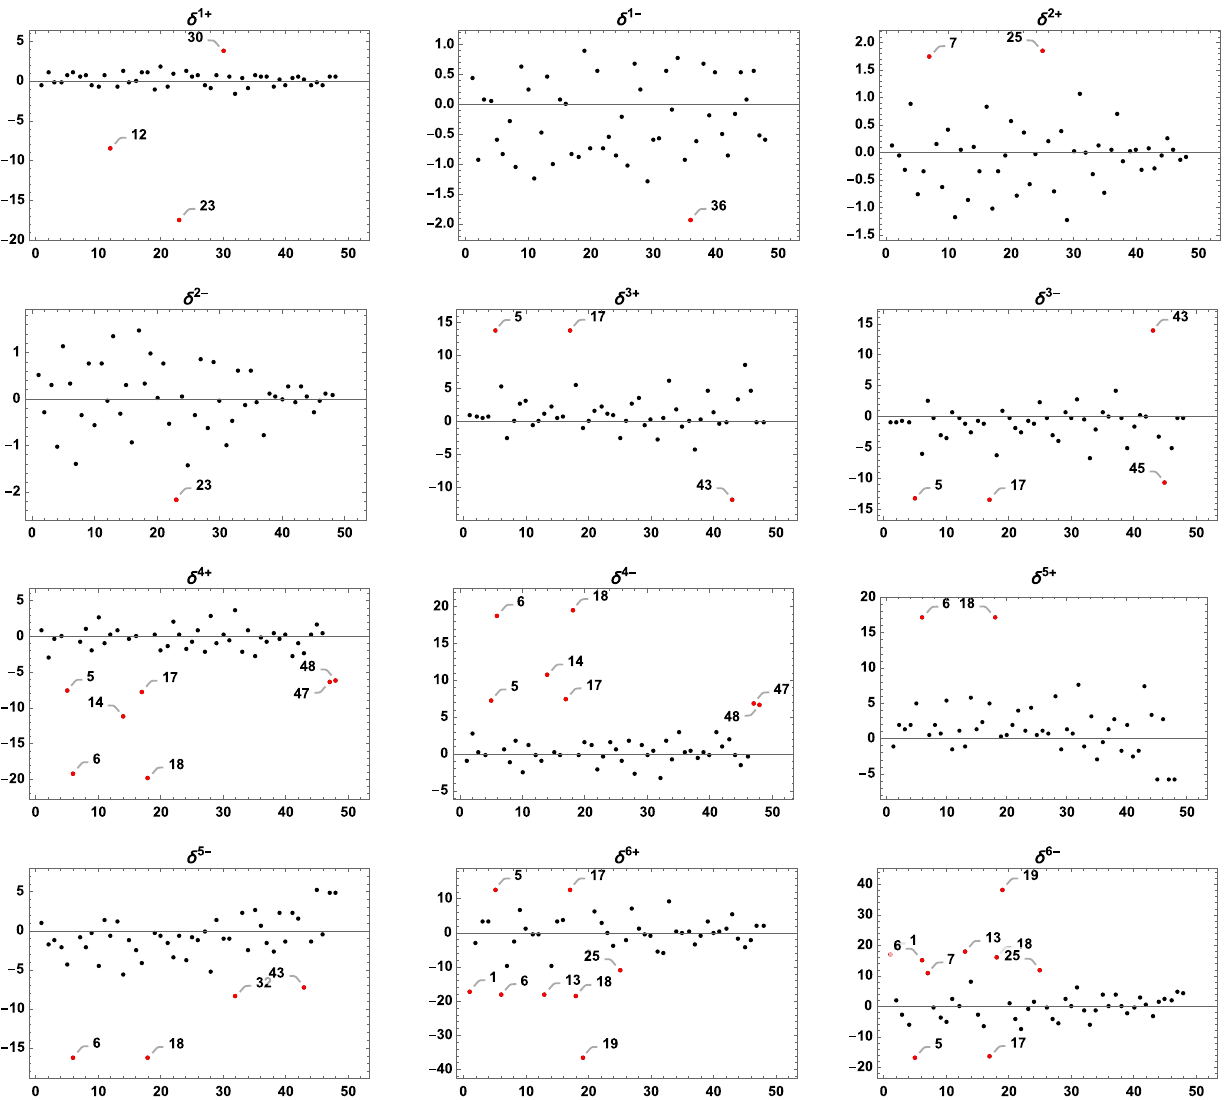
Fig. 11 Value of δ for the proposed observables listed in Table 14 for the 12 SVD directions. The largest ones for each case are highlighted in red and